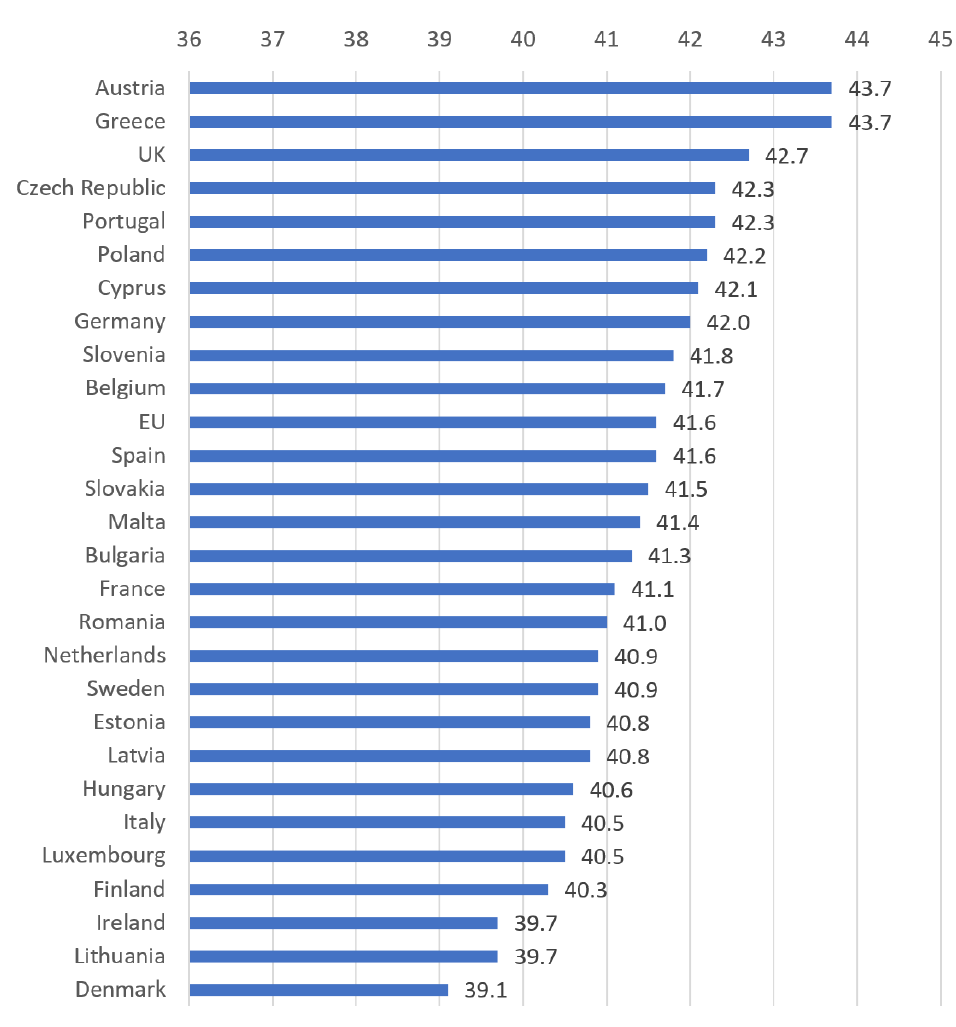
Figure 6: Average of real worked hours by European countries,